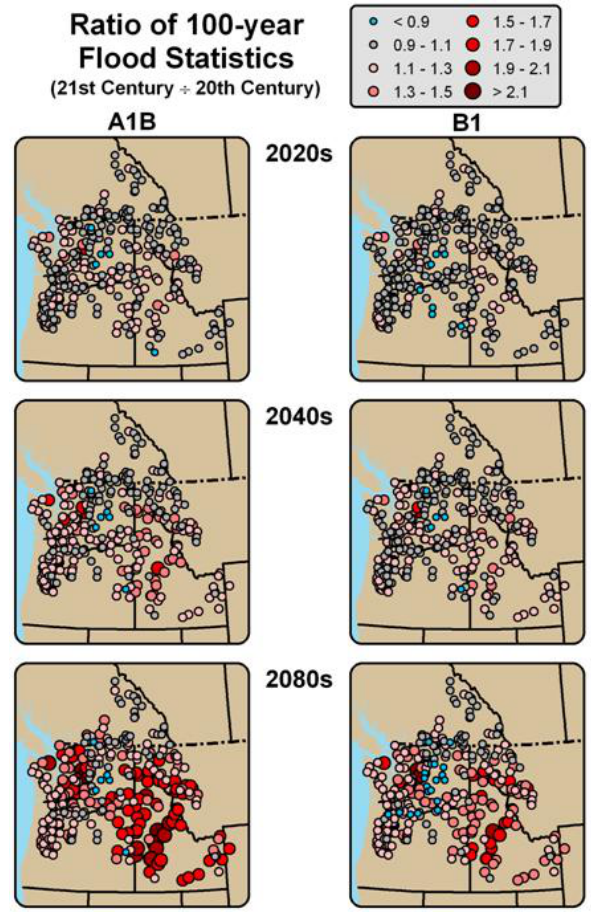
Fig. 5. Maps of the ratio (future/historical) of the 100-yr flood Figure 5: Maps of the ratio of the 100-year flood magnitude (future/ historical) for three future time 996 magnitude for three future time intervals, under two scenarios for intervals, under two scenarios for a 297 river locations in the PNW. (Higher ratios indicate more intense 997 a 297 river locations in the PNW. (Higher ratios indicate more in- tense flooding events projected for the future). Source: Tohver and flooding events projected for the future). Source: Tohver and Hamlet (2010) 998 Hamlet